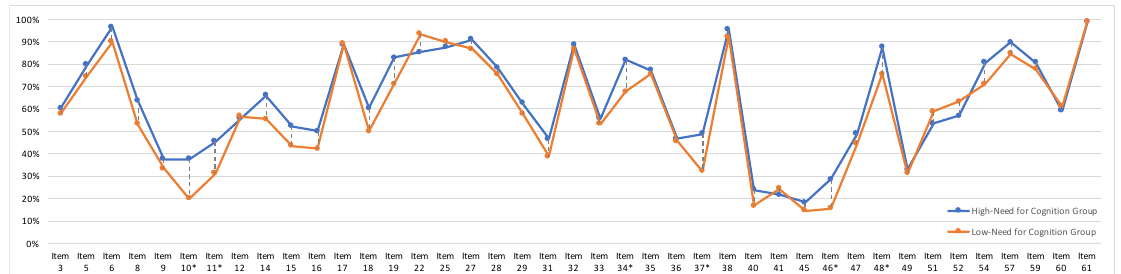
Figure 7. The percentages of high-need for cognition group and low-need for cognition group who answered Item i correctly. The asterisk marks indicate items that have a significant difference between the two groups based on the two-proportion Z -tests ( ∗ p <